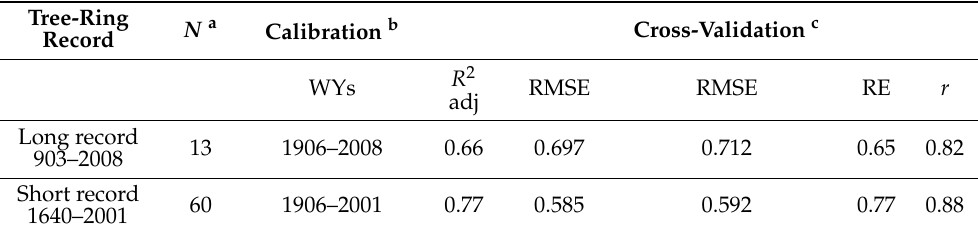
Table 3. Statistics for long record and short record tree-ring reconstructions (Model 1). Statistics are for regression models whose predictand is transformed 8RI flow (square root billion cubic